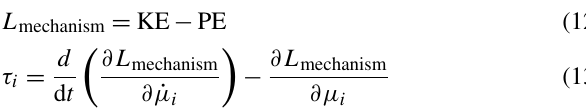
the vector of joint-space accelerations, ¨ µ ∈ (cid:60) 6 × 1 is the vec- tor of task-space accelerations and ˙ J ( µ ) ∈ (cid:60) 6 × 6 is the time derivative of the inverse Jacobian matrix of the